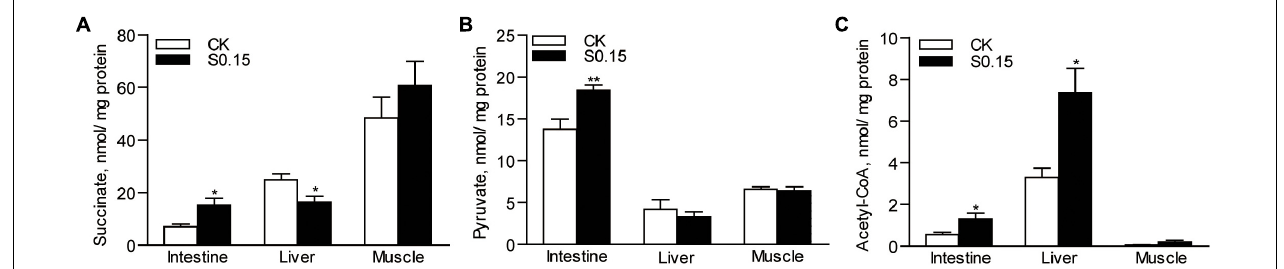
FIGURE 4 | Metabolic intermediates in zebrafish fed the CK or S0.15 diet for 4 weeks. (A) Intestinal, hepatic, and muscular succinate levels. (B) Intestinal, hepatic, and muscular pyruvate contents. (C) Intestinal, hepatic, and muscular acetyl-CoA contents. Values are means ± SEMs ( n = 5 biological replicates). * p < 0.05, ** p < 0.01. CK, control-check diet; S0.15, 0.15% succinate-supplemented